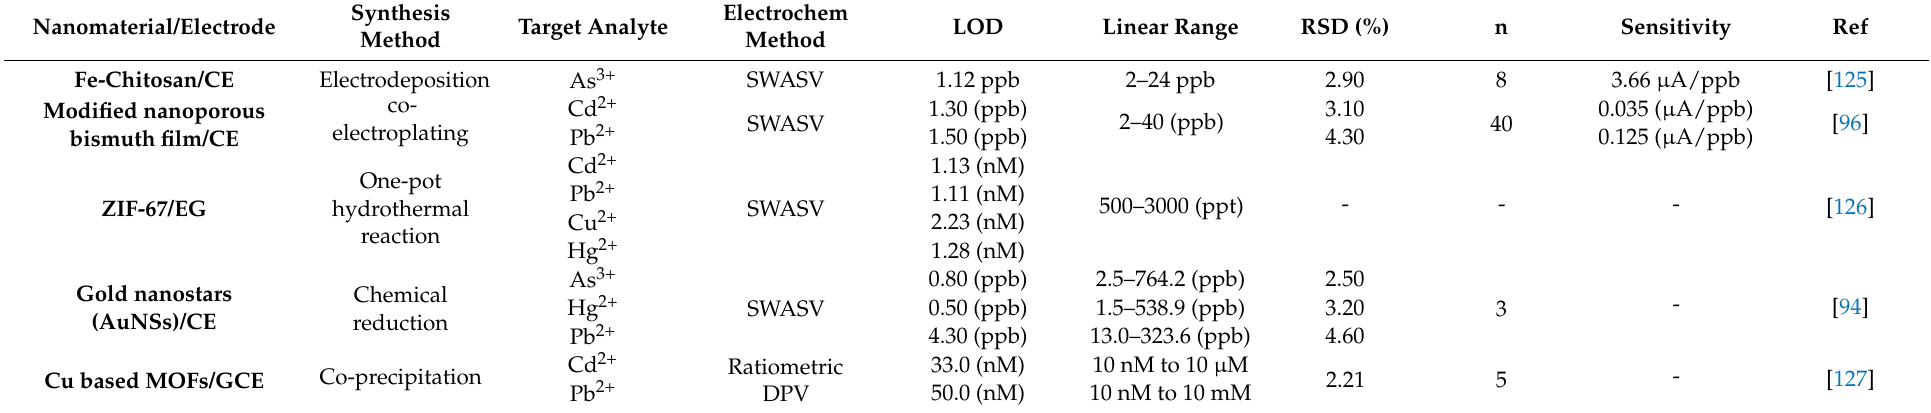
Table 2. Electroanalytical performances of selected transition metal-based nanocomposites as nanosensors for trace metal detection in water